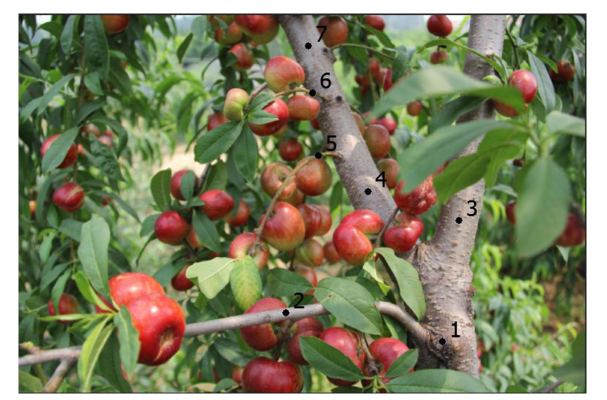
FIGURE 1 | The phenotypic characterization of the flat peach and its bud sport at maturity. Label 1 indicates the main branch, under this label all fruits produced were flat; labels 2, 3 show two lateral branches containing flat fruits; label 4 indicates a bud sport branch, whose two sub-branches (labels 5, 6) bore both flat and round fruits; branches above label 7 bore round-type fruit only. This picture was photographed at 66 DAB (days after blooming) at fruit